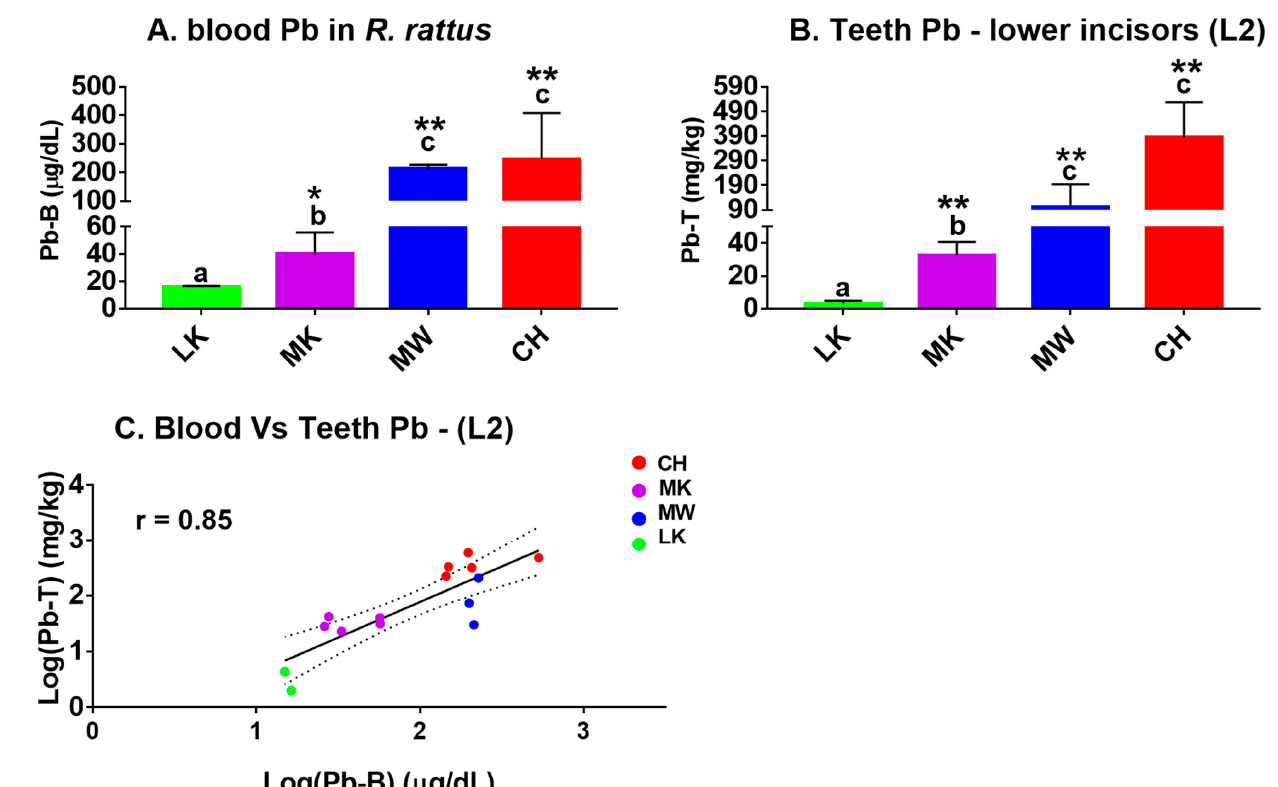
Figure 5. Mean ± SD of Pb-B and Pb-T of Pb-exposed R. rattus rats. ( A ) Pb-B from rats sampled from Lukanga (LK; n = 2); Makululu (MK; n = 5); Mutwe Wansofu (MW; n = 3) and Chowa (CH; n = 5). ( B ) Pb-T from rats sampled from LK ( n = 2); MK ( n = 5); MW ( n = 3), and CH ( n = 5); The lower case letters a, b, and c represent significant differences among the groups using the Tukey’s multiple comparison test ( p < 0.05). For the both Pb-B and the Pb-T, * at p < 0.05 and ** at p < 0.01 represent significant difference between the LK site (control group) and other groups sampled closer to the former Pb–Zn mine using the Turkey’s test. ( C ) Log-transformed Pearson’s correlations of Pb-B versus Pb-T in R. rattus rats ( r = 0.85, p < 0.01).